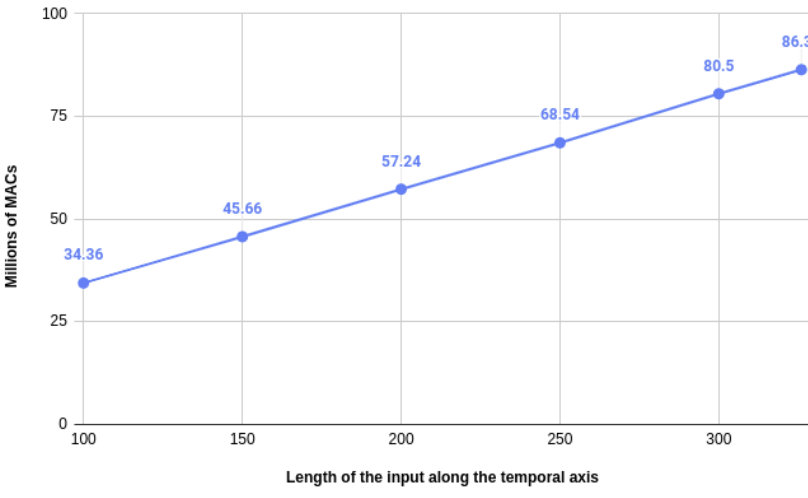
Figure 8. Learning curves assessing the accuracy obtained on the test set ( Y axis) relative to the number of training epochs ( X axis) for different amounts of zero-padding. MAC, multiply and accumulate.